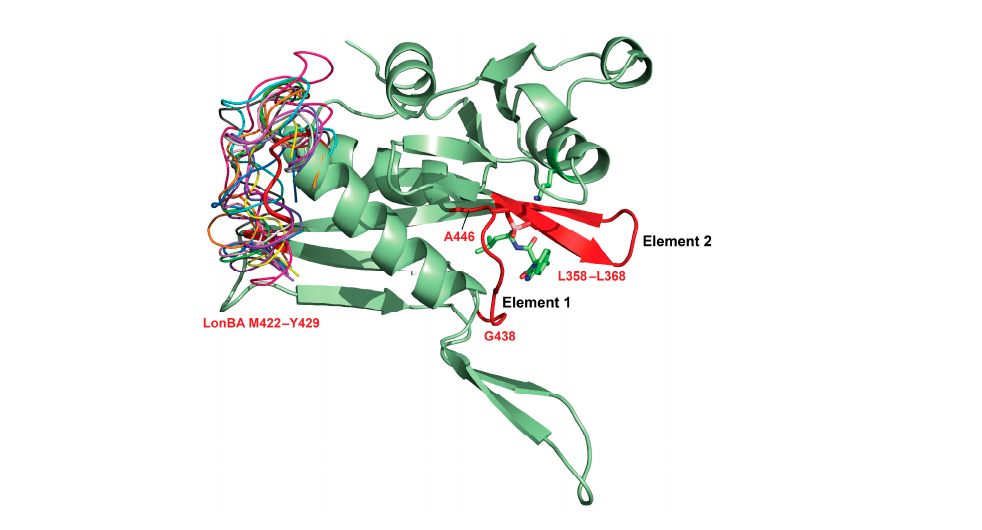
Figure 7. Mobile areas of the P domains of Lon proteases. Overall cartoon structure of the Bs LonBA P domain (pale green) is used to highlight the mobile areas in various Lons. The first mobile area is a flexible surface loop (residues 422–429 in Bs LonBA) with different lengths and conformations in all subfamilies of Lons from different sources (color coded). The other two mobile areas involve a fragment containing the catalytic Ser residue (residues 438–446 in Bs LonBA, Element 1 shown in red) and an adjacent β -loop comprising residues 358–368 (Element 2 shown in red). The inhibitor, bortezomib, is shown in sticks.